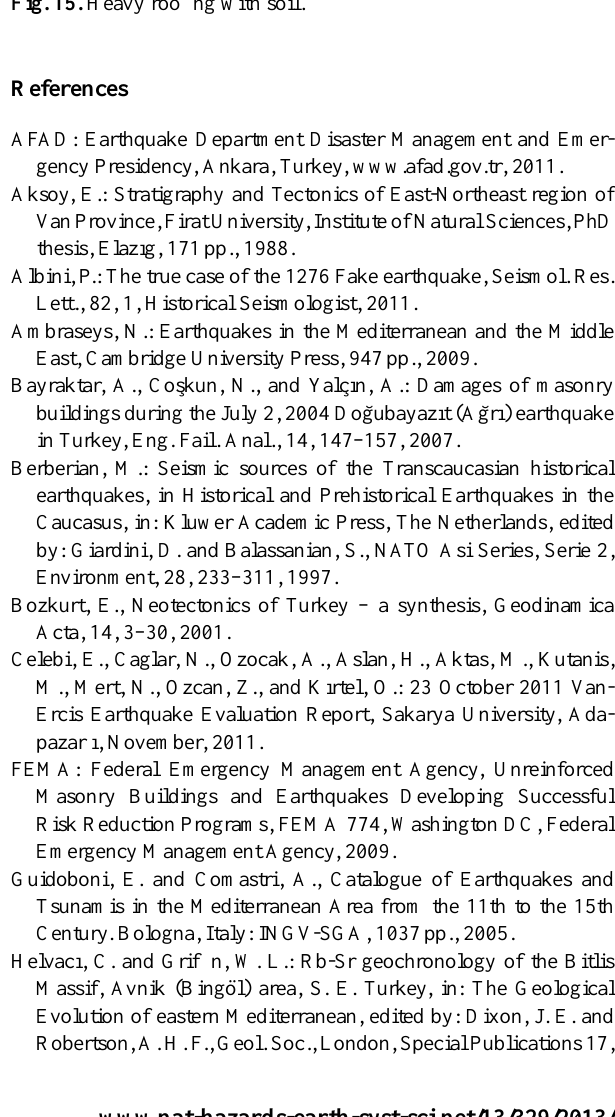
Fig. 15. Heavy roofing with soil